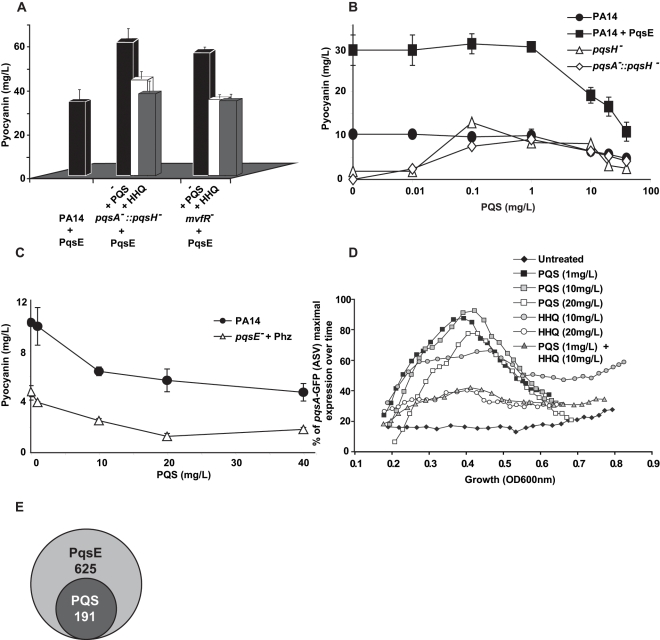
Negative homeostatic feedback regulation on MvfR regulon products and activity is mediated via cell-cell signaling molecule concentration.(A) Pyocyanin levels were assessed in PA14 and mutants cells harboring the plasmid pDN19pqsE with or without the addition of PQS or HHQ (20 mg/L). t-tests (p<0.05) showed that the difference between untreated and PQS/HHQ treated cells was statistically significant (B–C) Pyocyanin levels were determined following the addition of PQS over a broad-range of concentrations using a PQS non-producing strain (B) or using a narrow range of PQS concentrations in PQS-producing strains (C). PqsE was constitutively expressed (+PqsE). The empty vector was used as a control. phz genes were expressed following co-culture of pqsE− cells constitutively expressing phzA2-G2 with pqsE− cells constitutively expressing the phzM and phzS genes. The cells were grown in the presence of exogenously added PQS and pyocyanin production measured by measuring the OD600 nm. (D) The expression of pqsA was determined using a pqsA-GFP (ASV) fusion in a pqsA-::pqsH− double mutant in the presence of various concentrations of HHQ and PQS. (E) A Venn diagram showing the number of PqsE-regulated genes counterbalanced by PQS. The data was adapted from Table S1.